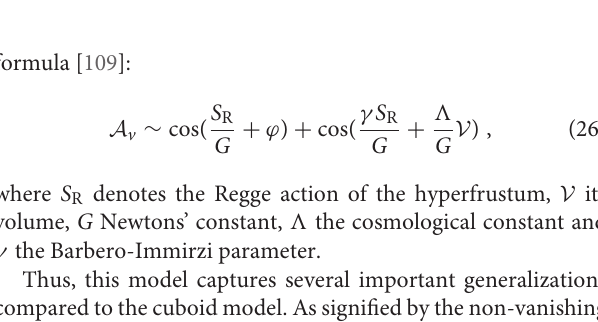
FIGURE 15 | (Left) cuboid intertwiners are peaked on the classical discrete geometry of a 3D cuboid. (Right) the construction of the frusta vertex amplitude from the contraction of